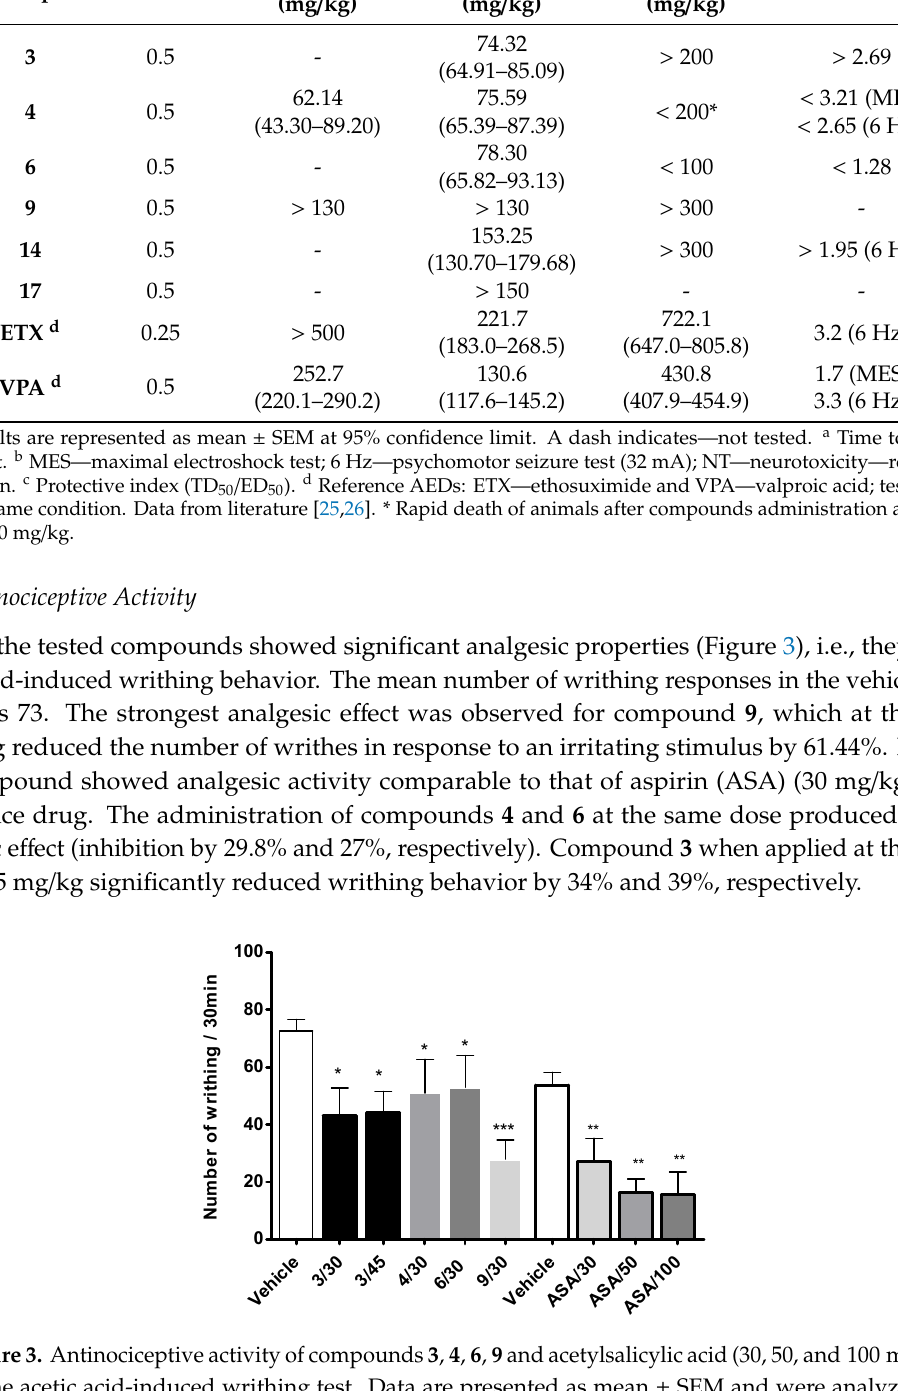
Table 3. Quantitative pharmacological parameters ED 50 , TD 50 , and PI in mice ip.